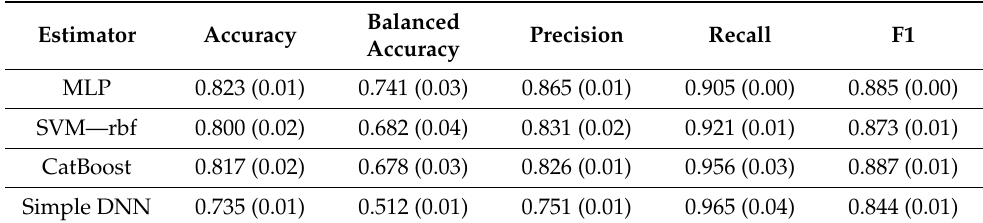
Table 6. Performances for advanced classification task 3: separate Parkinson’s disease from differen- tial diagnoses. Values correspond to mean (SD). MLP = multi-layer perceptron, SVM—rbf = support vector machine—radial basis function, simple DNN = simple deep neural network.